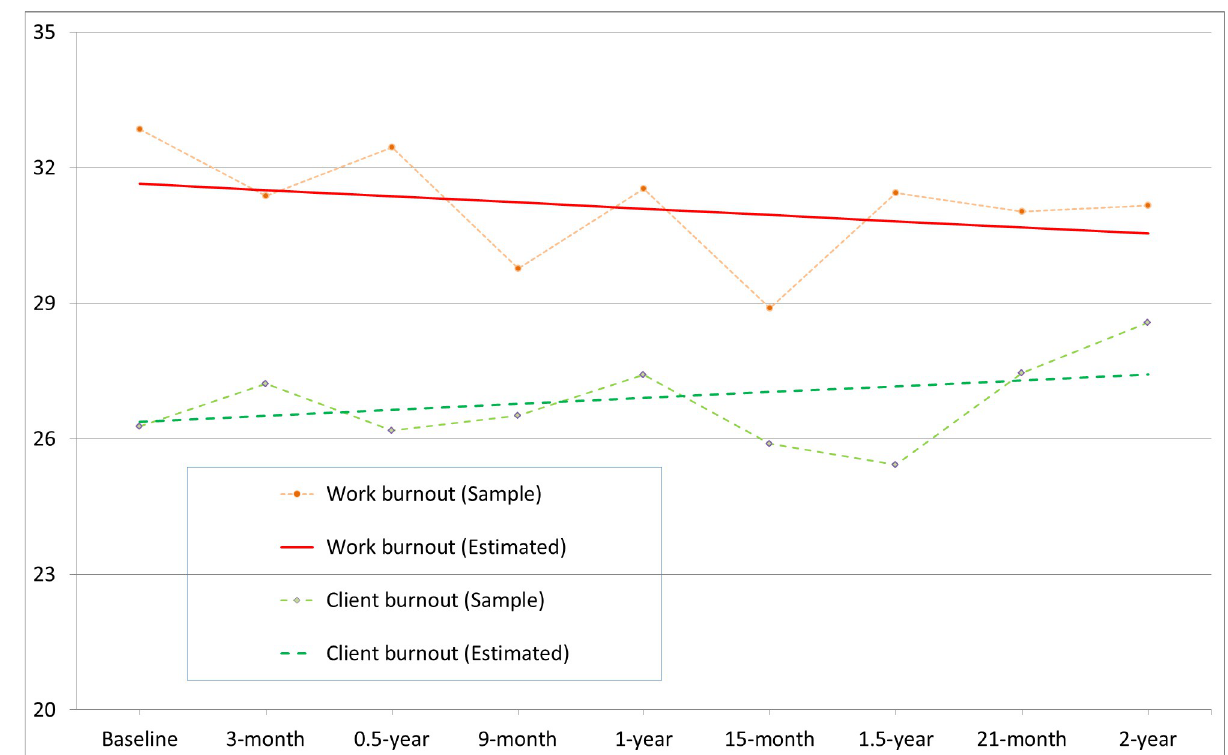
Fig 2. Developmental trajectories of work burnout and client burnout in the child care workers.